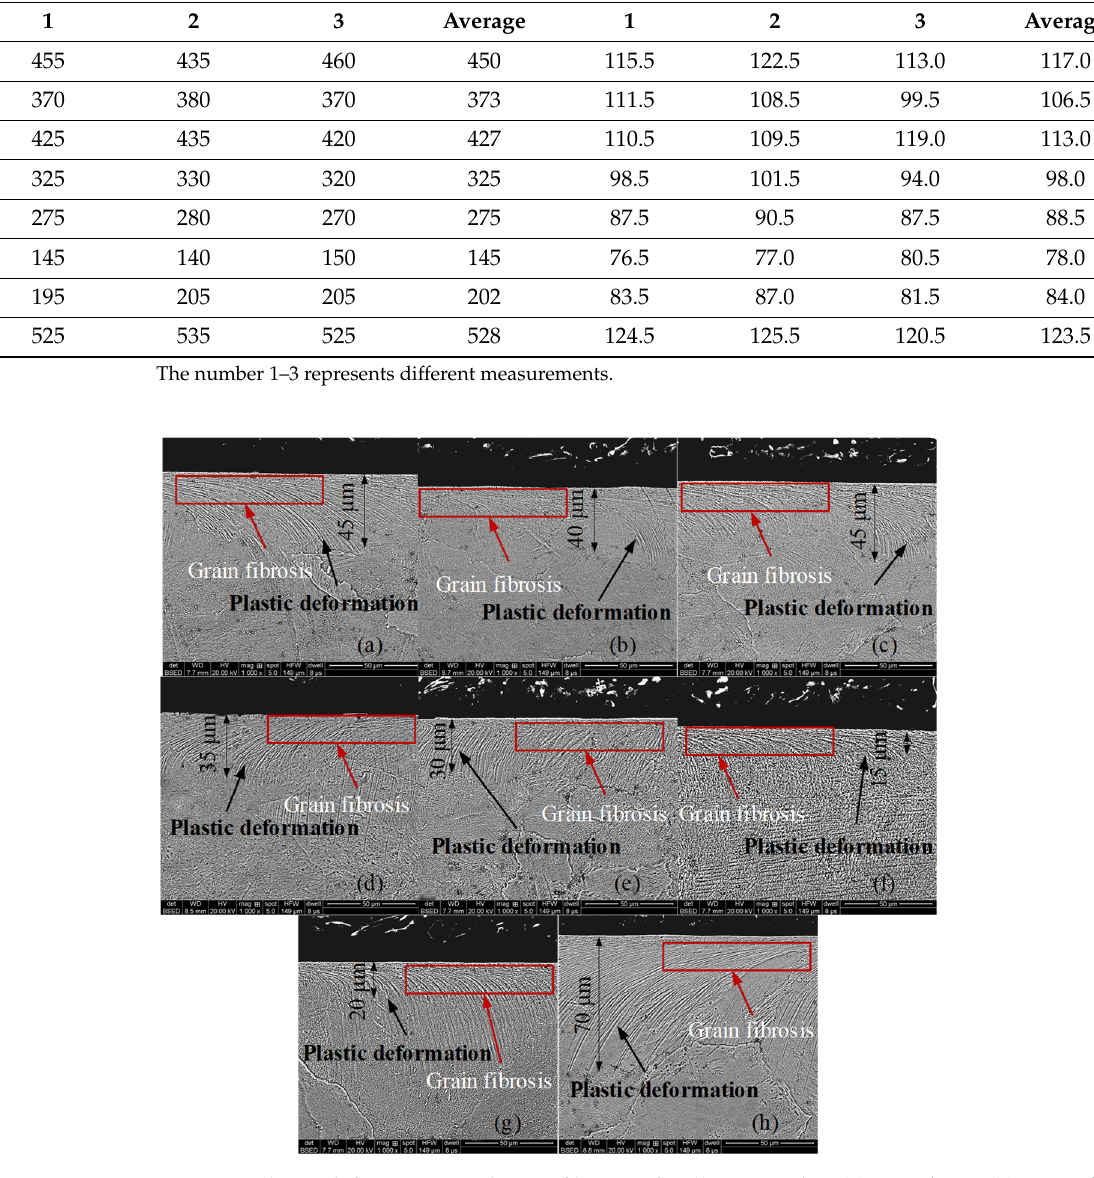
Table 1. Depth of work hardening layer ( D H ) and hardening degree ( N ) of milled surface.